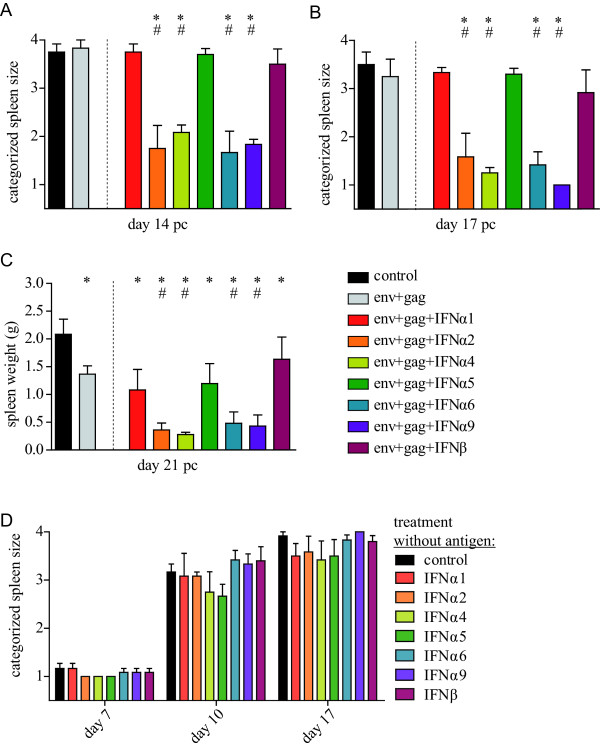
FV-induced splenomegaly in adenoviral vector immunized mice. CB6F1 mice were immunized with Ad5 and Ad5F35 based vectors encoding F-MuLV Env and Gag with or without co-administration of a specific vectored type I IFN subtype, as indicated. Ad5-based vectors were used for the prime immunization and Ad5F35 vectors for the boost immunization. Mice of the group "env+gag" received an equal amount of luciferase encoding adenoviral vectors instead of IFN encoding vectors to ensure that the total amount of particles used for immunization was the same in all groups. Three weeks after the boost immunization mice were challenged with FV. Disease progression was monitored by palpation of the spleen twice a week. The categorized spleens of six mice per group on day 14 p.c. (A) and day 17 p.c. (B) are shown (means + standard error of the means). On day 21 p.c. spleens were removed and weighed (C). Statistically significant differences (P < 0.05) compared to unvaccinated control mice (*) or mice vaccinated with Env- plus Gag-encoding vectors (#) are indicated. Data are representative of two independent experiments. (D) CB6F1 mice were immunized twice with Ad5 and Ad5F35 based vectors encoding the indicated type I interferons alone and infected with FV three weeks after the second application of IFN vectors. The disease progression was monitored by twice-weekly palpations of the spleen, the graph shows the categorized spleen sizes (mean + standard error of the means) at the indicated time points after FV infection.